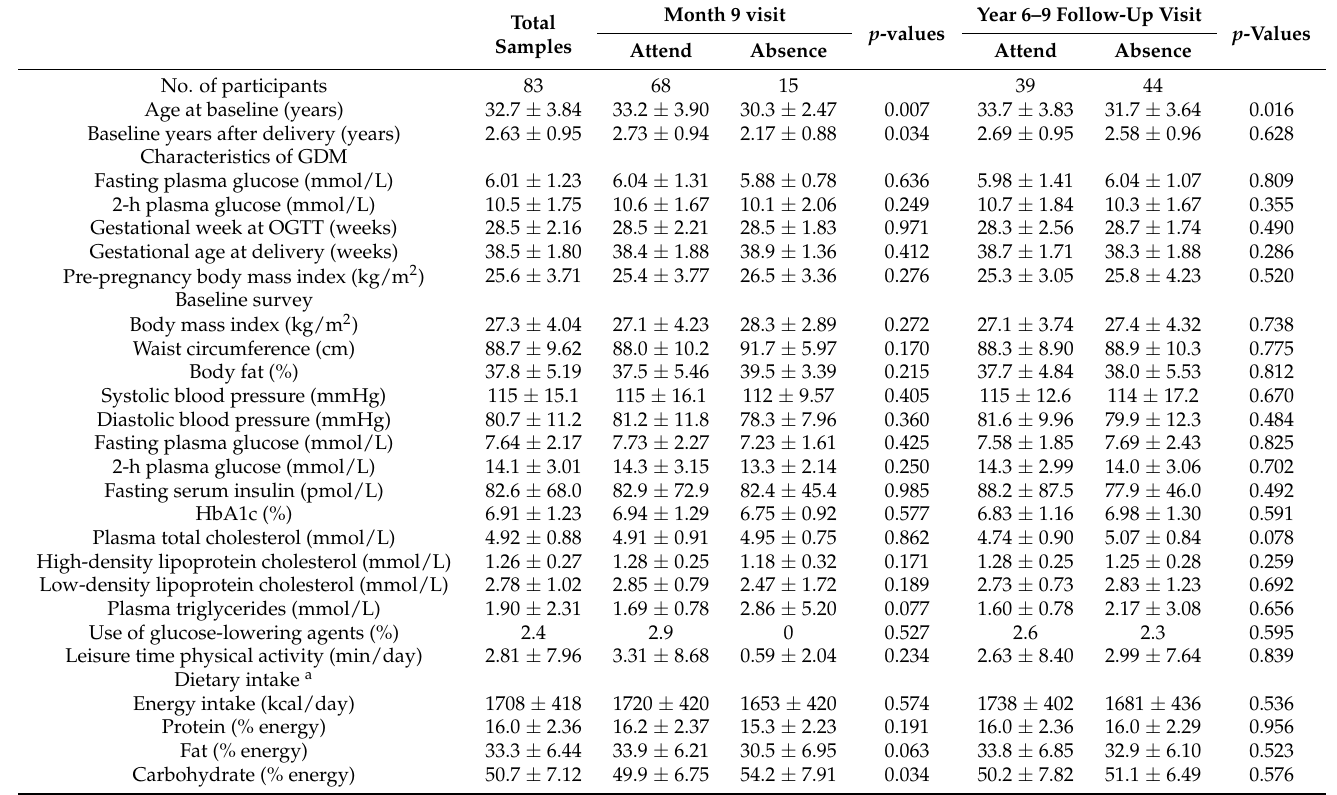
Table 1. Baseline characteristics among women with gestational diabetes mellitus (GDM) and newly diagnosed diabetes who attended and absented Month 9 and Years 6–9 follow-up visits. Month 9 visit Total p Samples